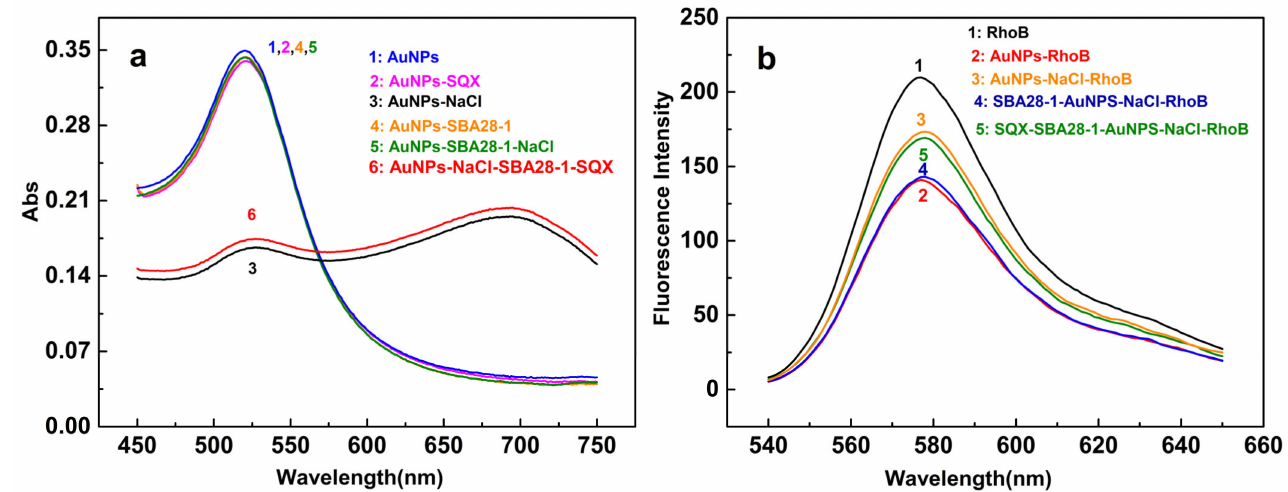
Figure 5. ( a ) Absorption spectra of AuNPs solutions in different samples; ( b ) Fluorescence spectra of RhoB in different